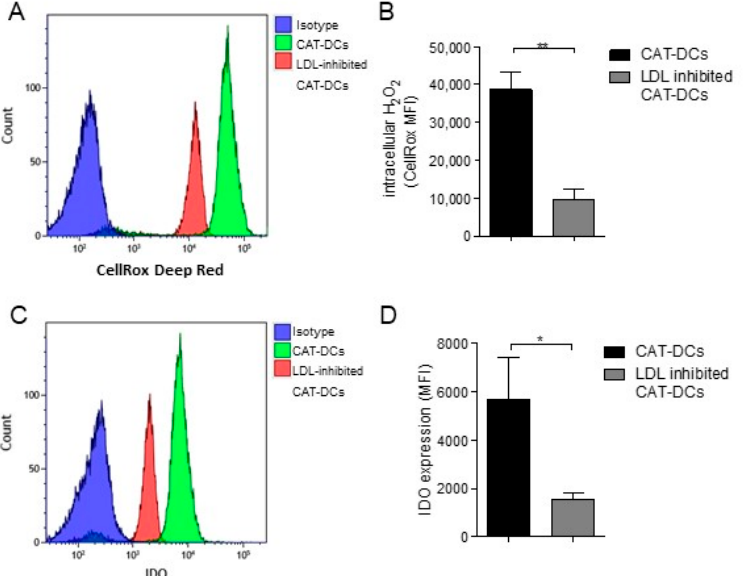
Figure 8. Intracellular H 2 O 2 -levels and LDL-uptake regulate IDO- and CD86-expression in CAT-DCs. ( A , B ) Measurement of relative H 2 O 2 levels of CAT-DCs by flow cytometry using CellRox Ultra Red for intracellular H 2 O 2 levels in LDL-uptake-inhibited CAT-DCs in comparison to CAT-DCs with uninhibited LDL uptake (A = representative plot, B : n = 5). ( C , D ) Analysis of IDO-expression in LDL-uptake-inhibited CAT-DCs in comparison to uninhibited CAT-DCs (C = representative plot, D: n = 5). Statistical analysis was performed with a paired two-tail Student’s t -test. (* p < 0.05, ** p < 0.01).